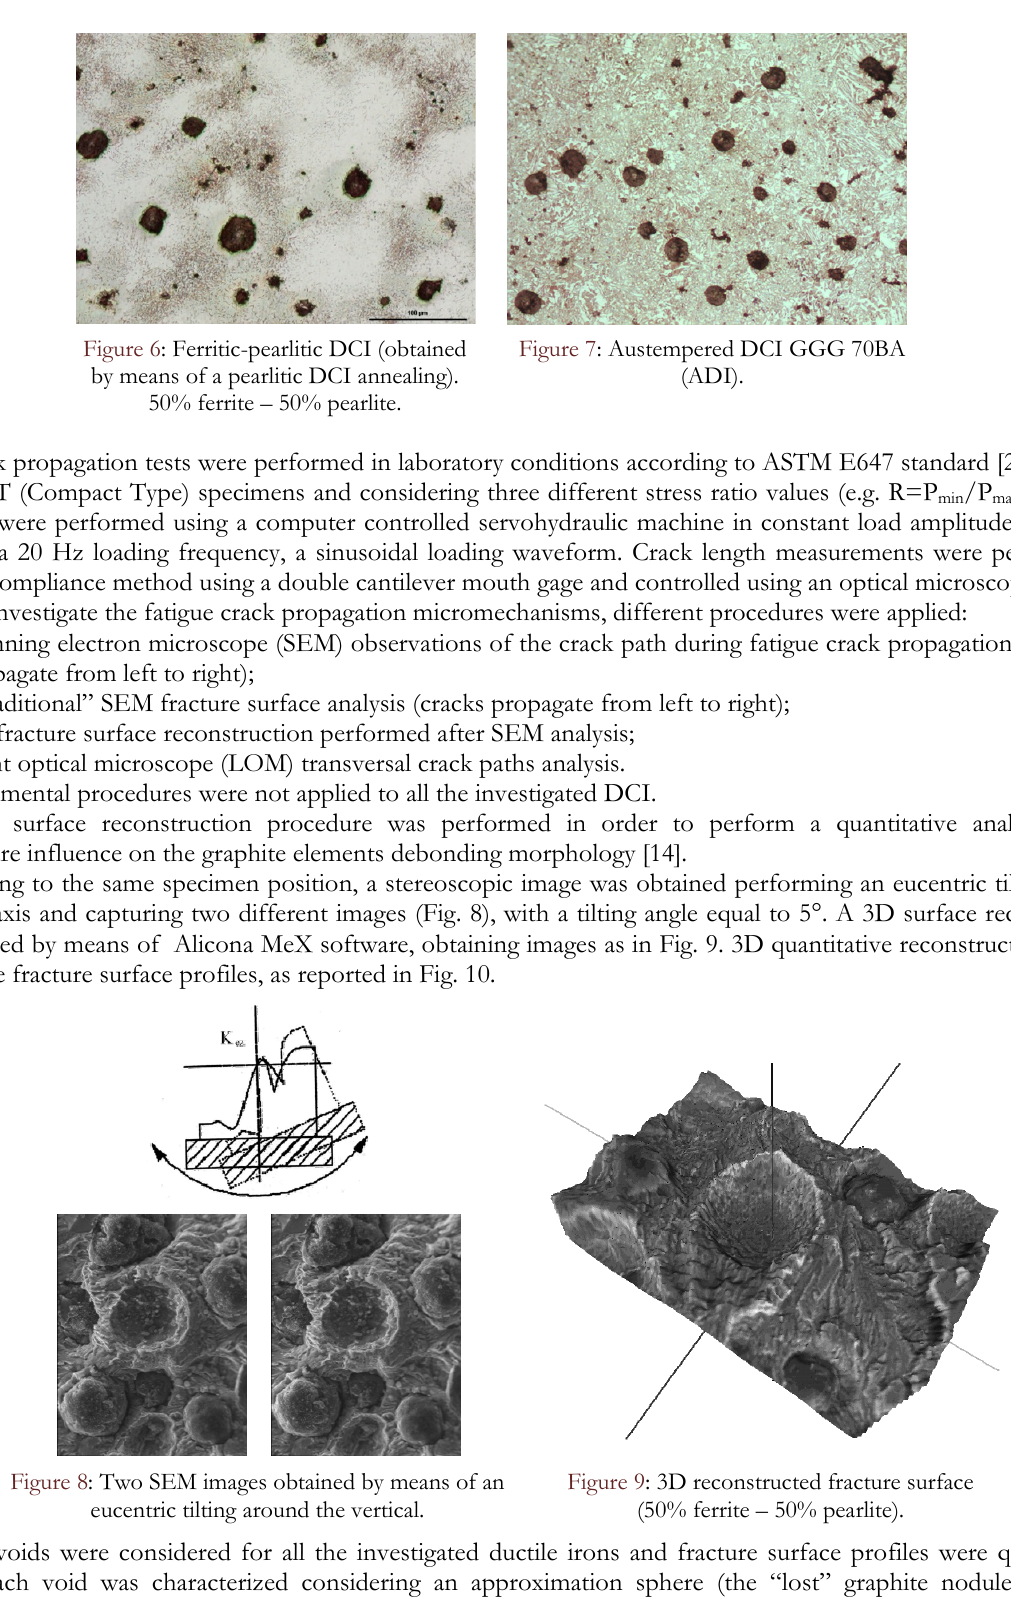
Figure 9: 3D reconstructed fracture surface (50% ferrite – 50%